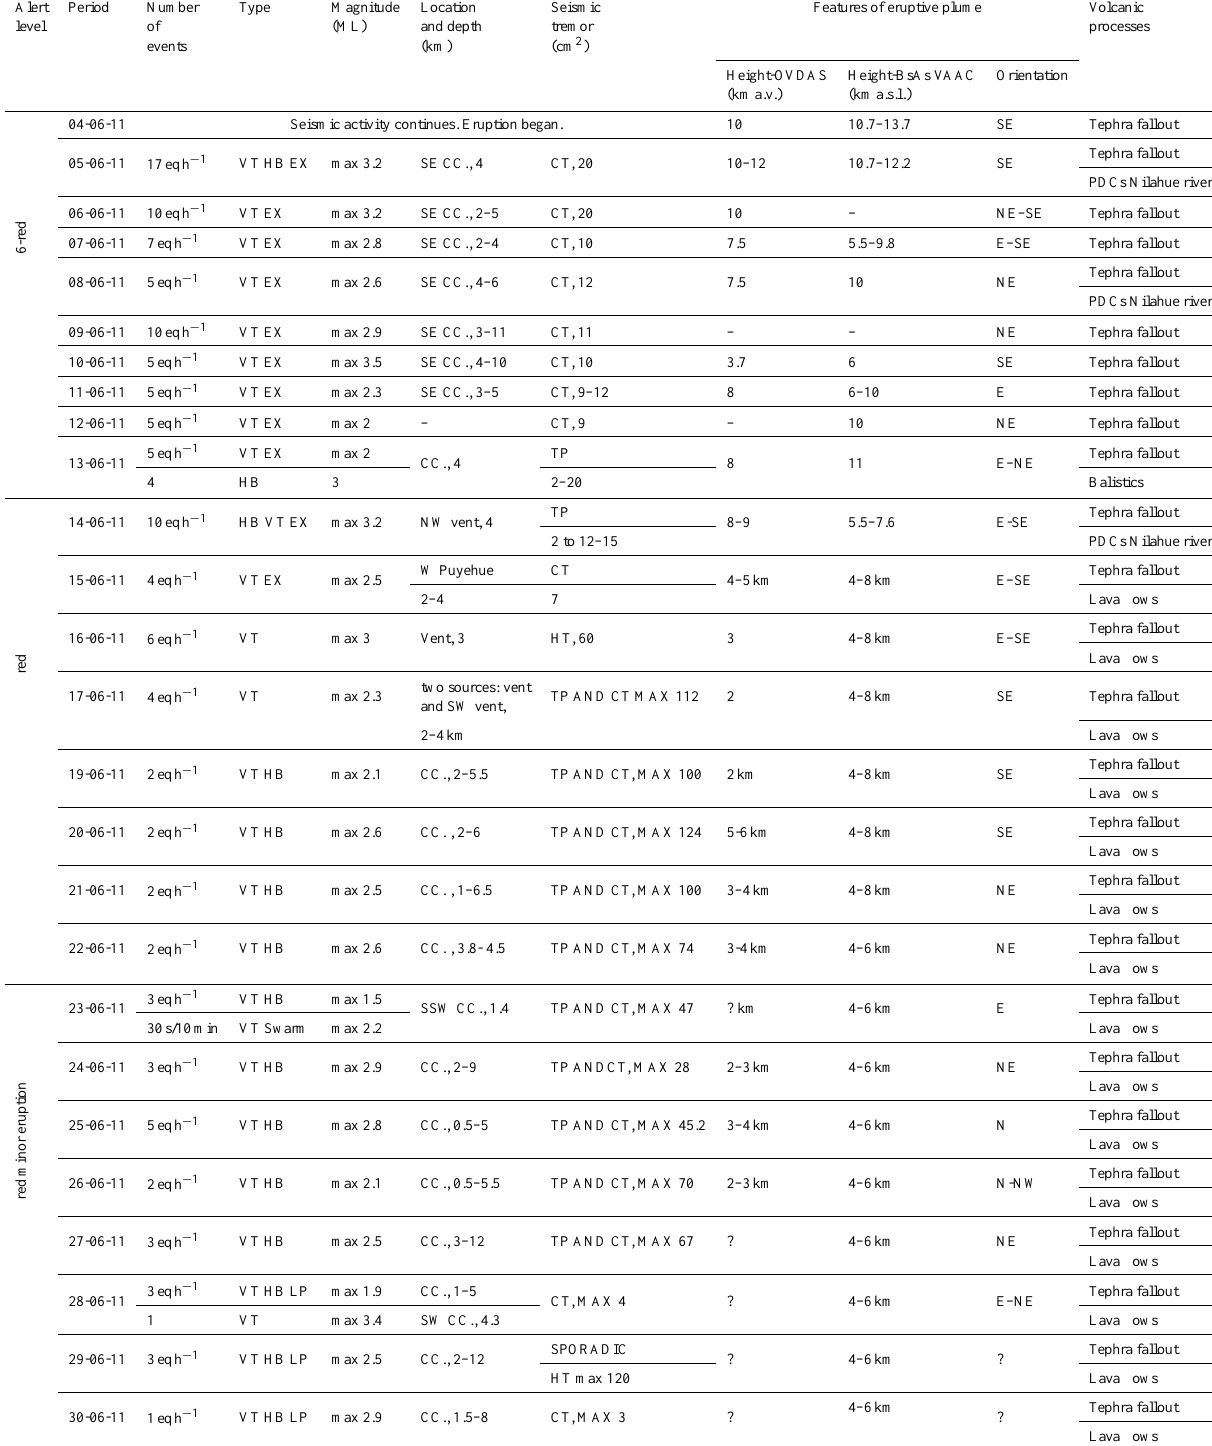
Table 2. Eruptive activity of the PCCVC during June 2011. The table includes alert level; type, number and location of earthquakes; seismic tremors; plume height and volcanic processes. ML: local magnitude, VT: volcano tectonic; LP: long period; HB: hybrid; LOFZ: Liquiñe– Ofqui fault zone, CC: Cordón Caulle; CT: continuous tremor; TP: tremor pulses; HT: harmonic tremor. Taken from SERNAGEOMIN- OVDAS, 2010–2012; Buenos Aires VAAC and satellite